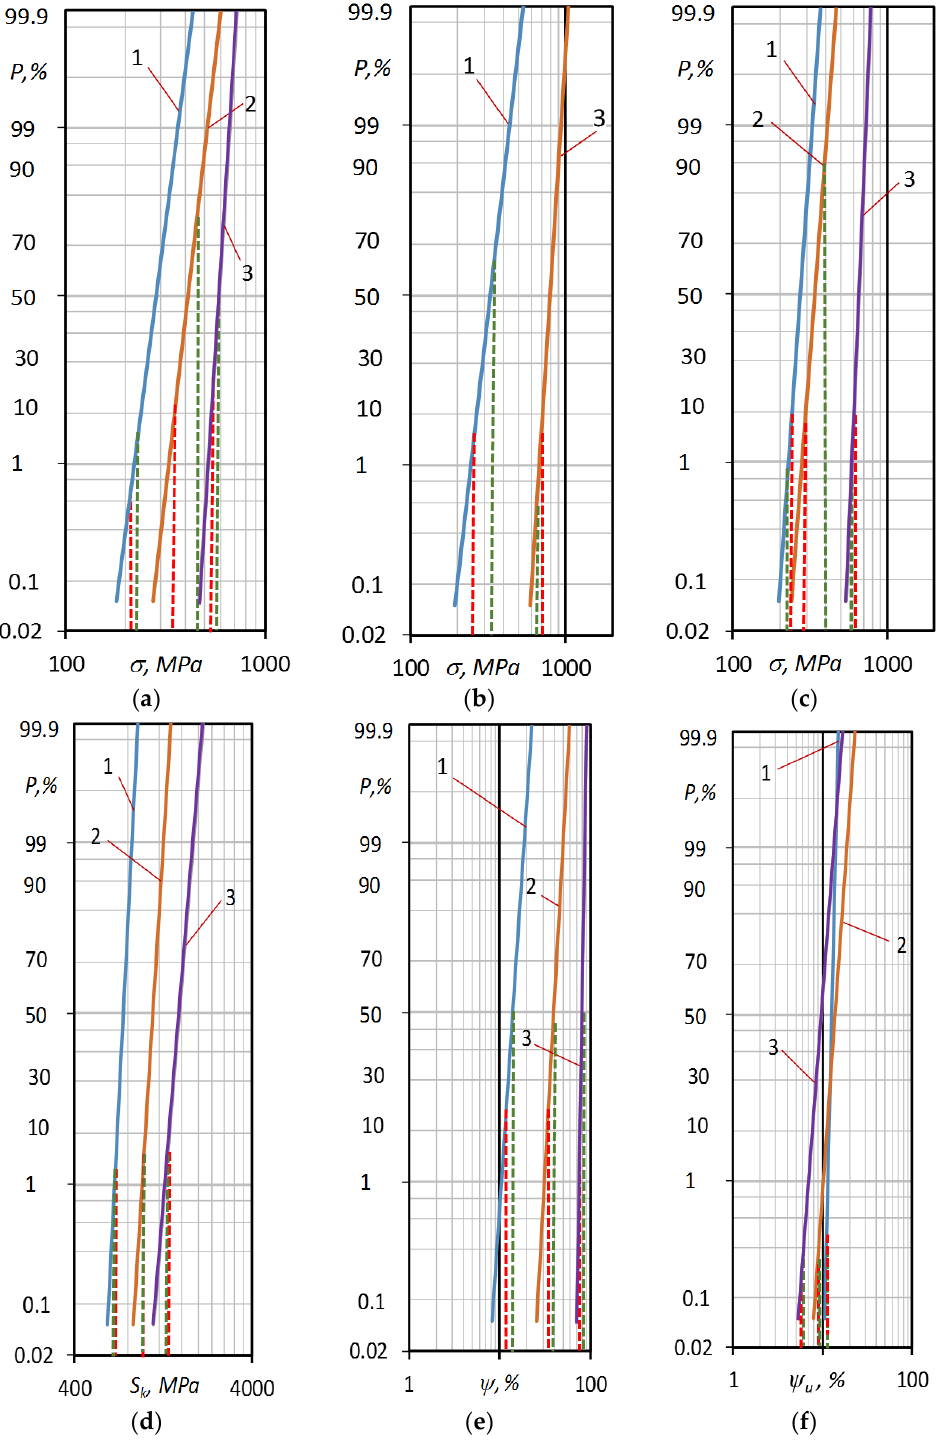
Figure 6. Log-normal distribution curves of the proportionality, relative yield, and strength limits: ( a ) steel 15Cr2MoVa; ( b ) steel C45; ( c ) aluminium alloy D16T1 (1 — σ pr ; 2 — σ 0.2 ; and 3 — σ u ); of the stress at failure ( d ), continuous ( e ), and percent area reduction at failure ( f ), 1 — steel 15Cr2MoVa; 2 — steel C45; 3 — aluminium alloy D16T1; — normalised values; — standard values.